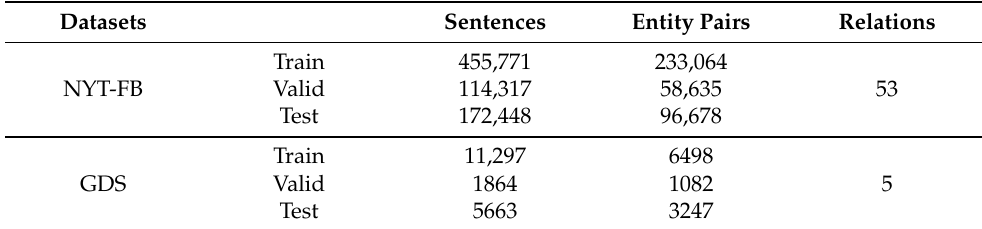
Table 1. A statistical comparison of the used datasets. Datasets